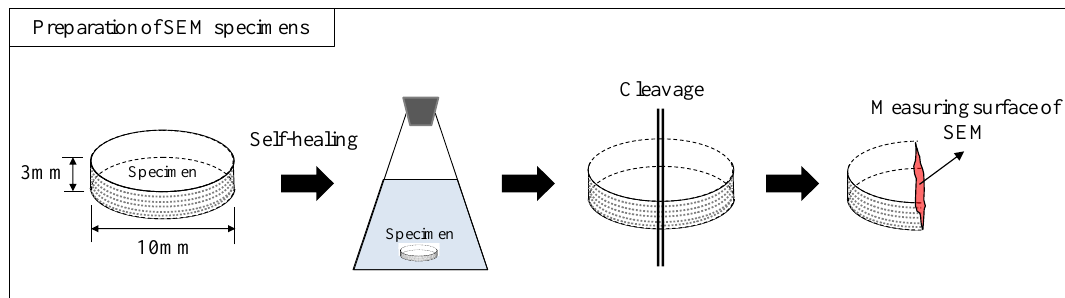
Figure 5. Sample preparation for SEM.